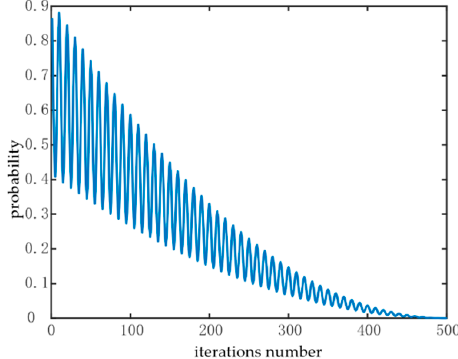
Figure 9. Cosine dynamic adaptive factor trend.